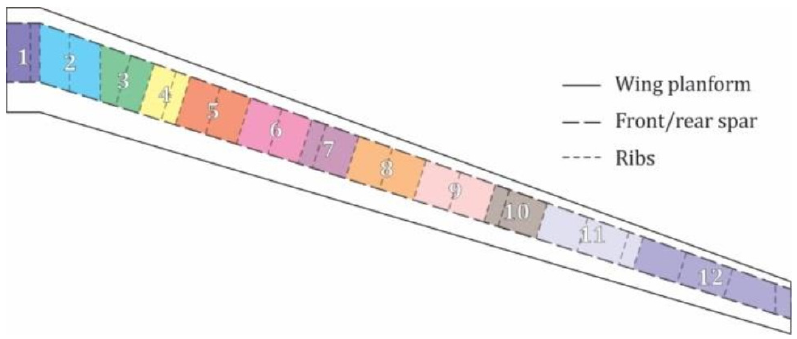
Figure 4. Wing design region distribution.